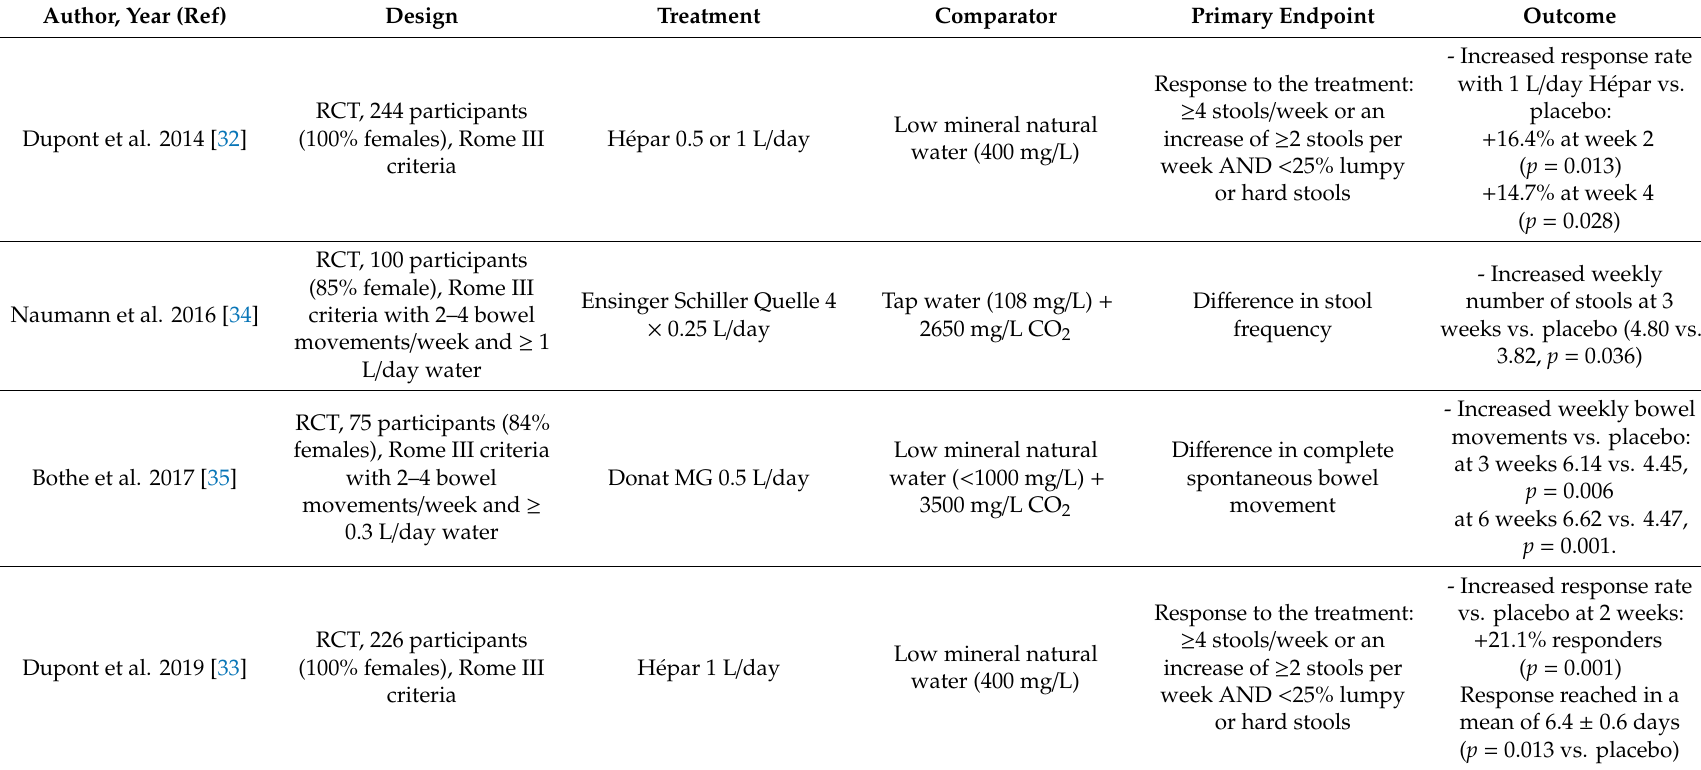
Table 3. Studies of the e ff ect of magnesium sulfate-rich mineral waters in functional